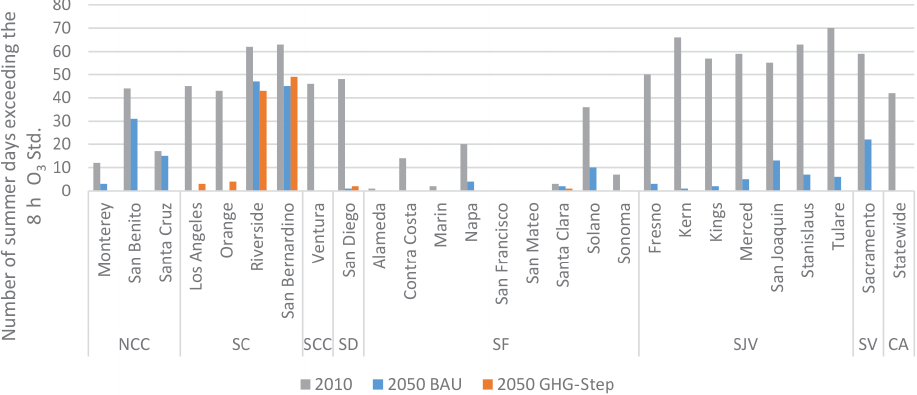
Figure 4. Number of days in the months of June–August 2054 in which the county population-weighted daily maximum 8h average ozone concentration exceeds the 8h ozone NAAQS of 70ppb for each current and future year